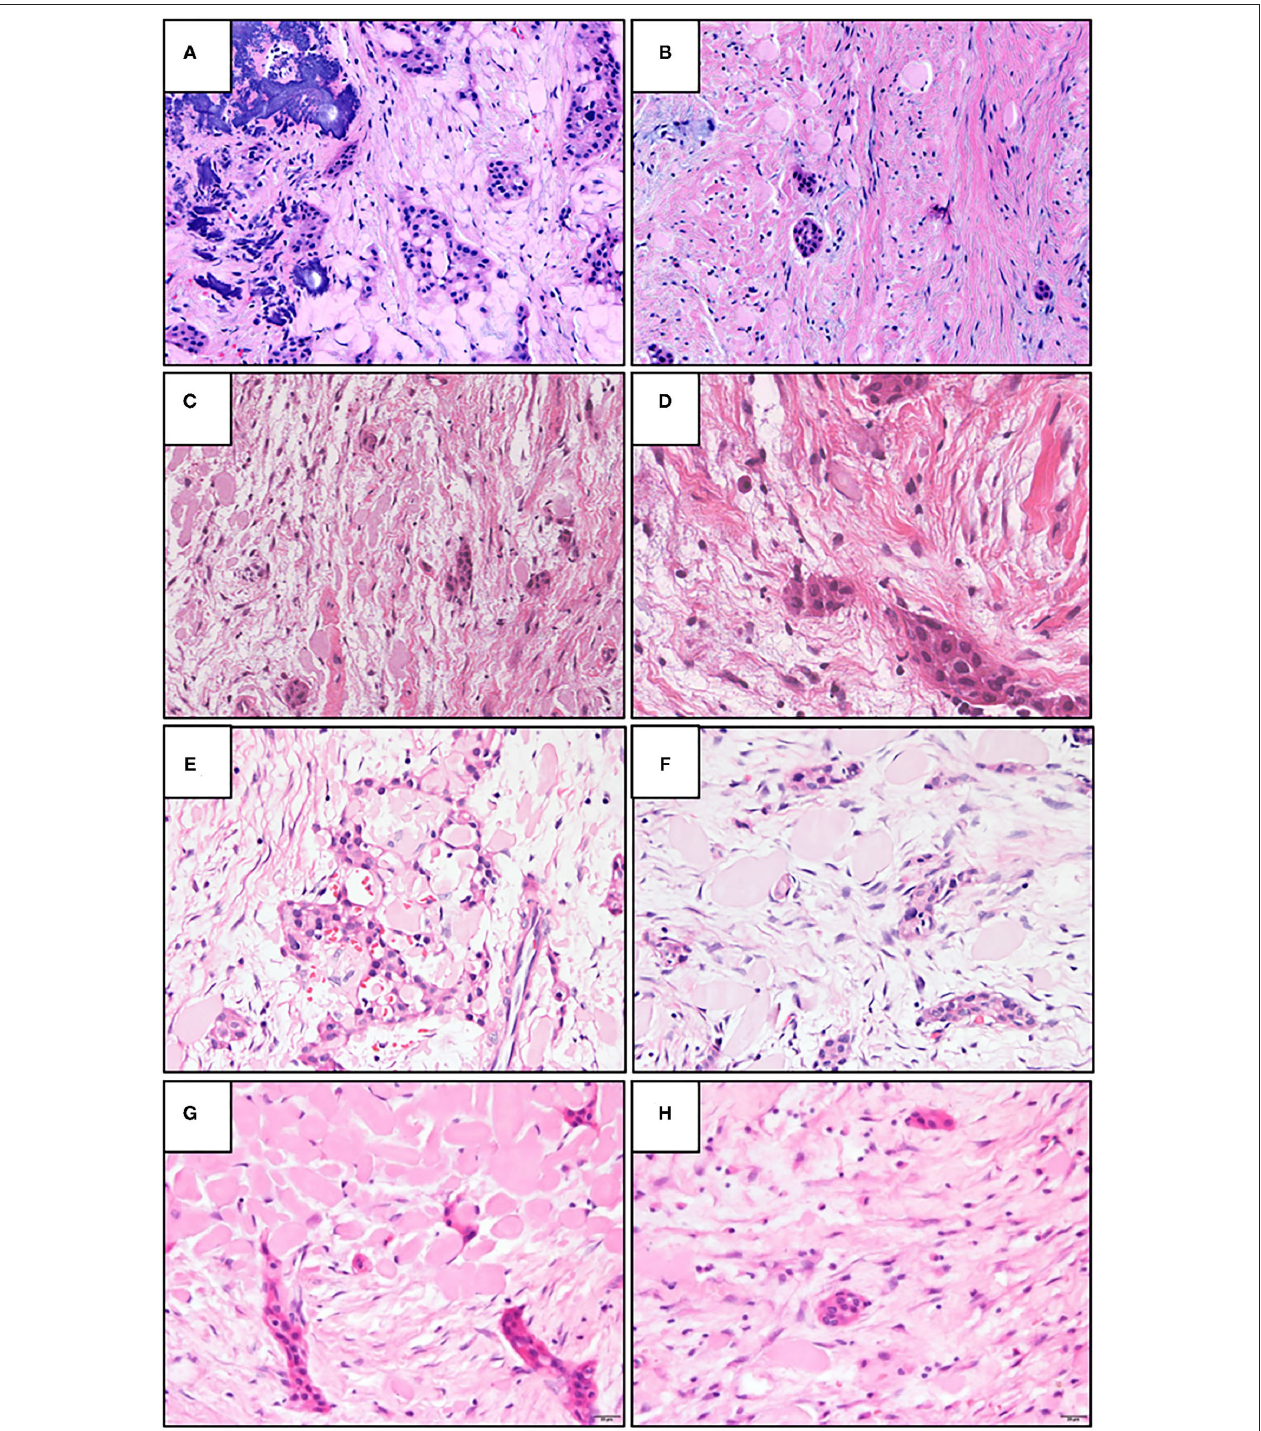
FIGURE 4 | The representative histopathologic photographs of CEOT, amyloid rich variant of the central odontogenic fibroma (AR-COF), and NCLC-CEOT. (A,B) A classic CEOT case with (A) showing the classic pattern and (B) showing the features like an AR-COF in the periphery of the same case. (C,D) An AR-COF case with (C) showing some amyloid-like materials dispersed in classic COF stromal background and (D) showing intercellular bridges and mild nuclear hyperchromatism in the odontogenic epithelial islands. (E,F) An NCLC-CEOT case 3 exhibiting strands or nests of odontogenic epithelium and amyloid materials in the fibrous connective tissue stroma. (G,H) An NCLC-CEOT case 6 demonstrating a network or nests of odontogenic epithelium and amyloid materials in the loose connective tissue stroma. H&E; A–C : 100 × ; D : 400 × ; E–H : 200 × .